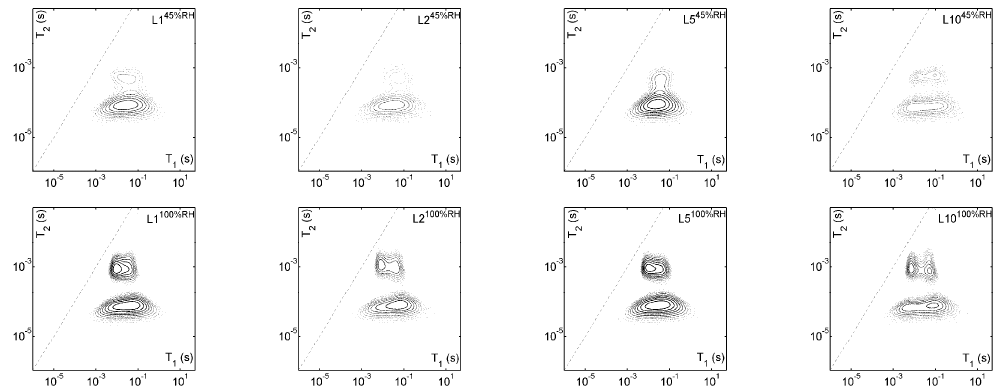
Figure 2. Two-dimensional nuclear magnetic resonance (2D 1 H-NMR) T 1 –T 2 maps of L 1 -, L 2 -, L 5 - and L 10 -sections collected at 45% (first row) and 100% (second row) relative humidity. The common greyscale bars are set to the highest intensity of both series, i.e., L 5 -map’s intensity acquired at 100% relative humidity (RH). The contours are equally spaced from 10% to 90% of the maximum intensity for each map. The dash-dot line corresponds to T 1 = T 2 .